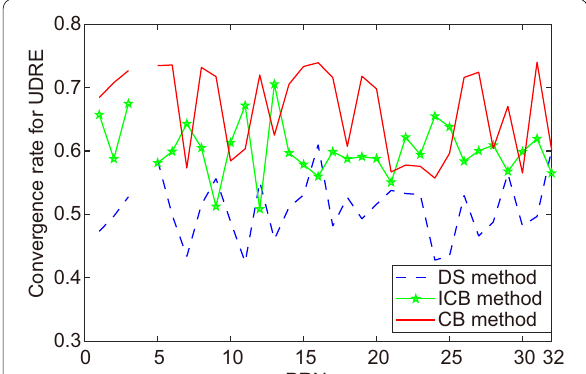
Fig. 4 Distribution of selected monitor stations